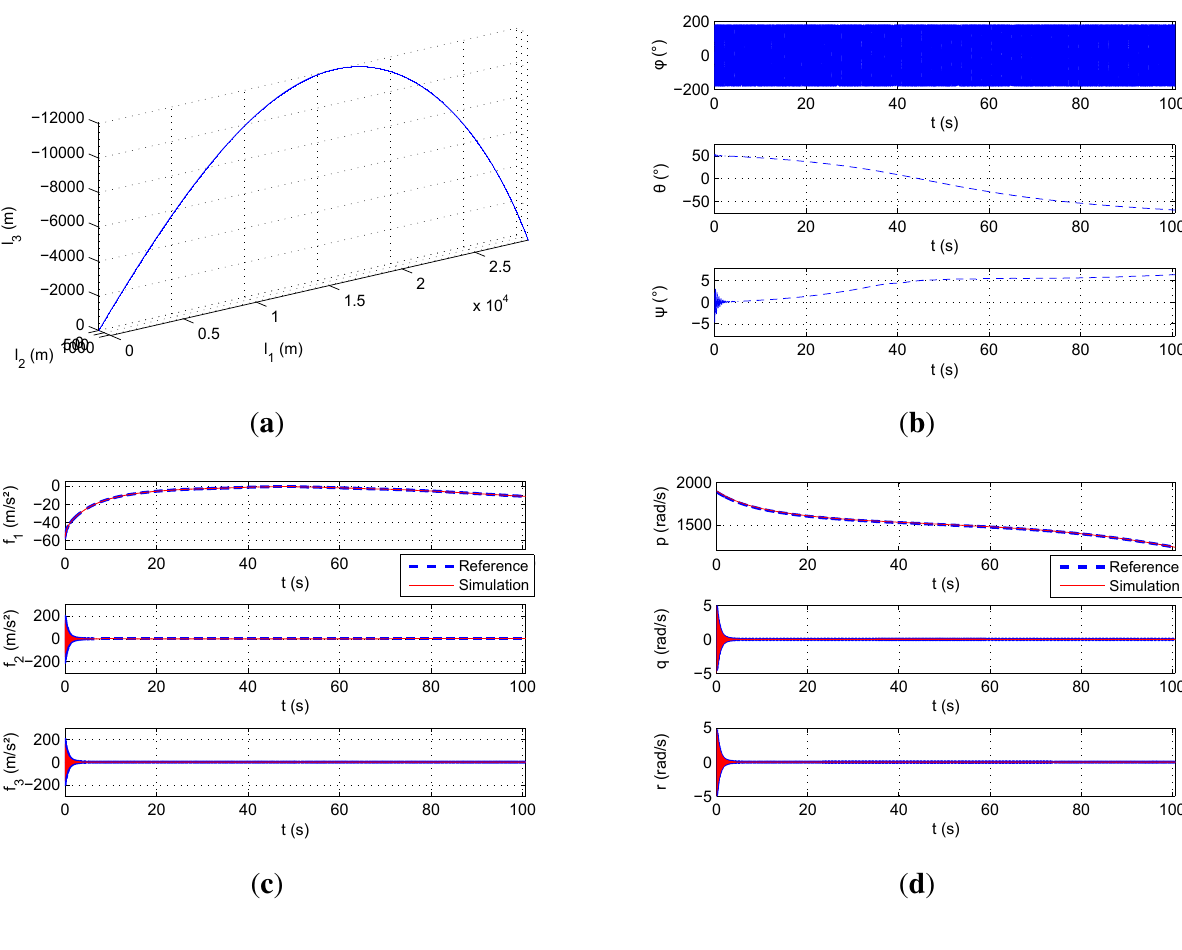
Figure 8. Validation plots thanks to the projectile simulator. ( a ) 3D trajectory of the gun-launched projectile; ( b ) Euler angles describing the orientation of the gyro-stabilized projectile. The stabilizing spin is around the first axis; ( c ) Comparison of the specific forces; ( d ) comparison of the rotational